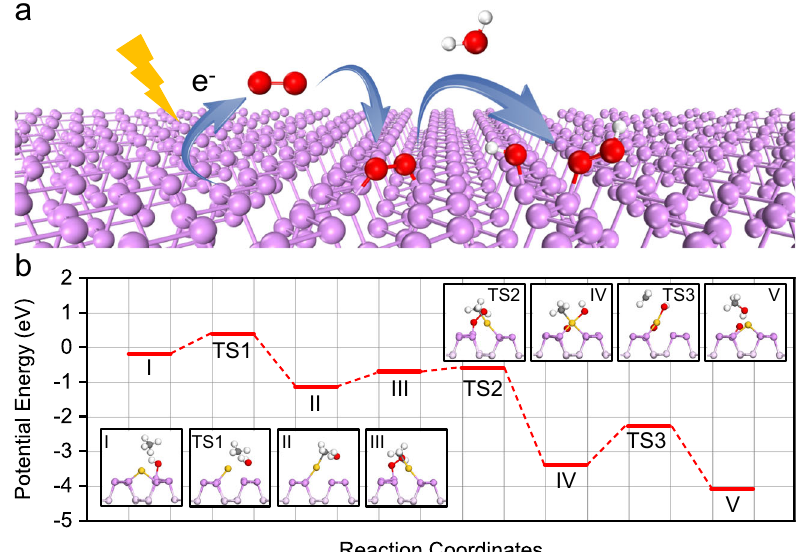
Fig. 4 DFT studies. a Schematic illustration of oxygen activation on BP nanosheets. b Reaction path for partial oxidation of methane over Au 1 /BP nanosheets under light irradiation. The inset images show the side views of the con fi gurations. Yellow, violet, pink, red, gray, and white spheres represent Au, surface P, subsurface P, O, C, and H atoms,